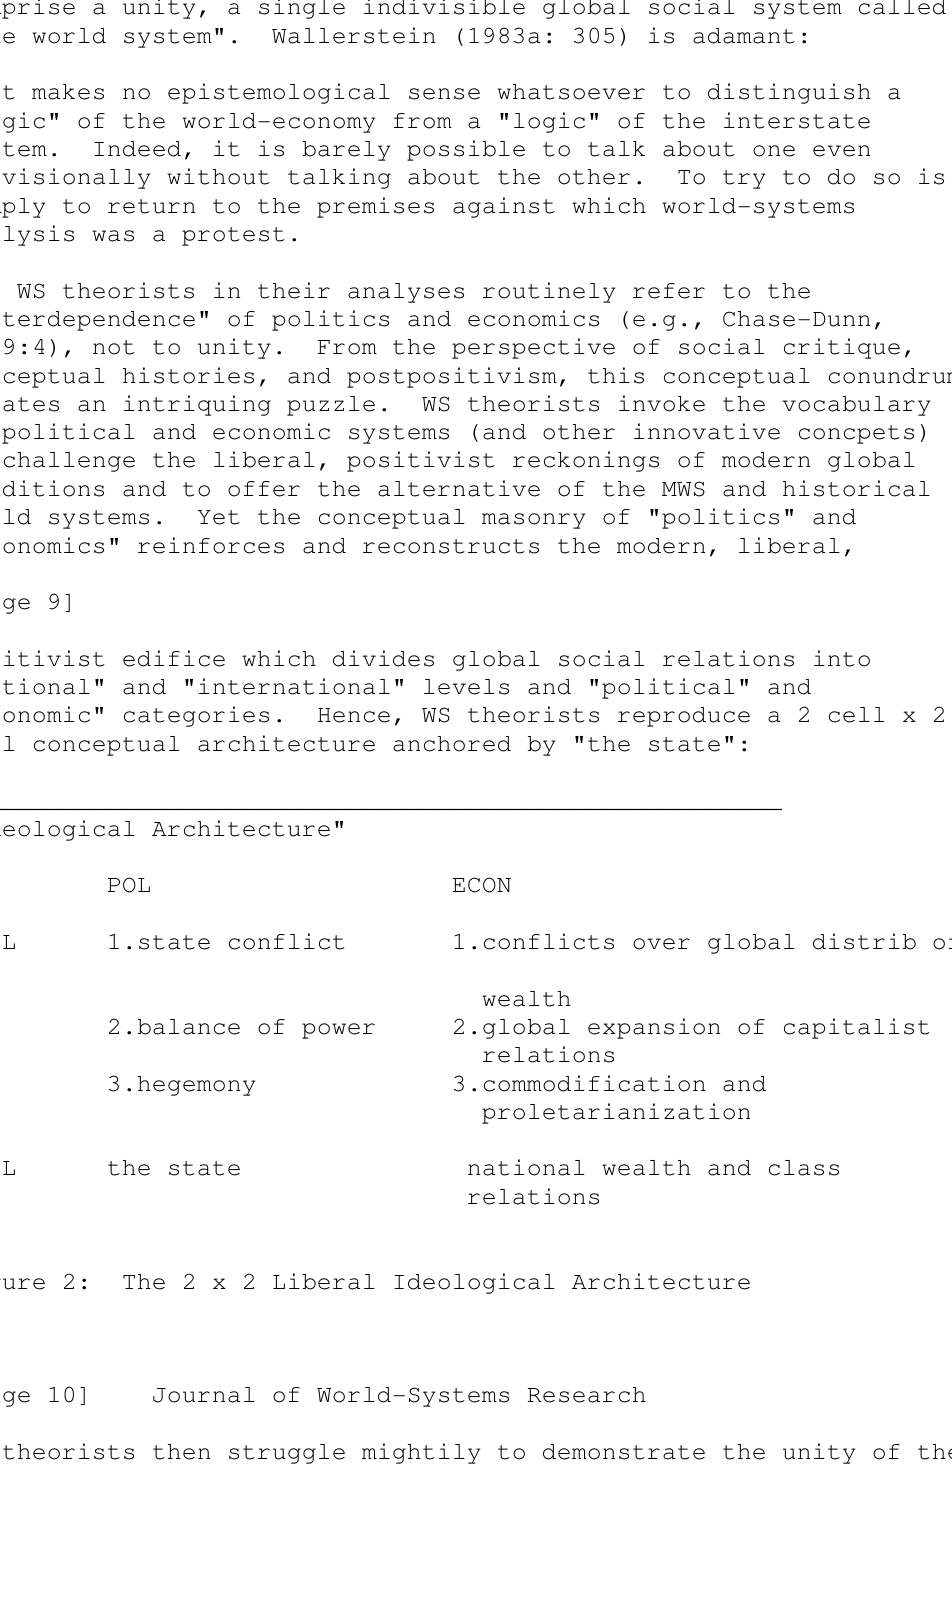
The 2 x 2 Liberal Ideological Architecture